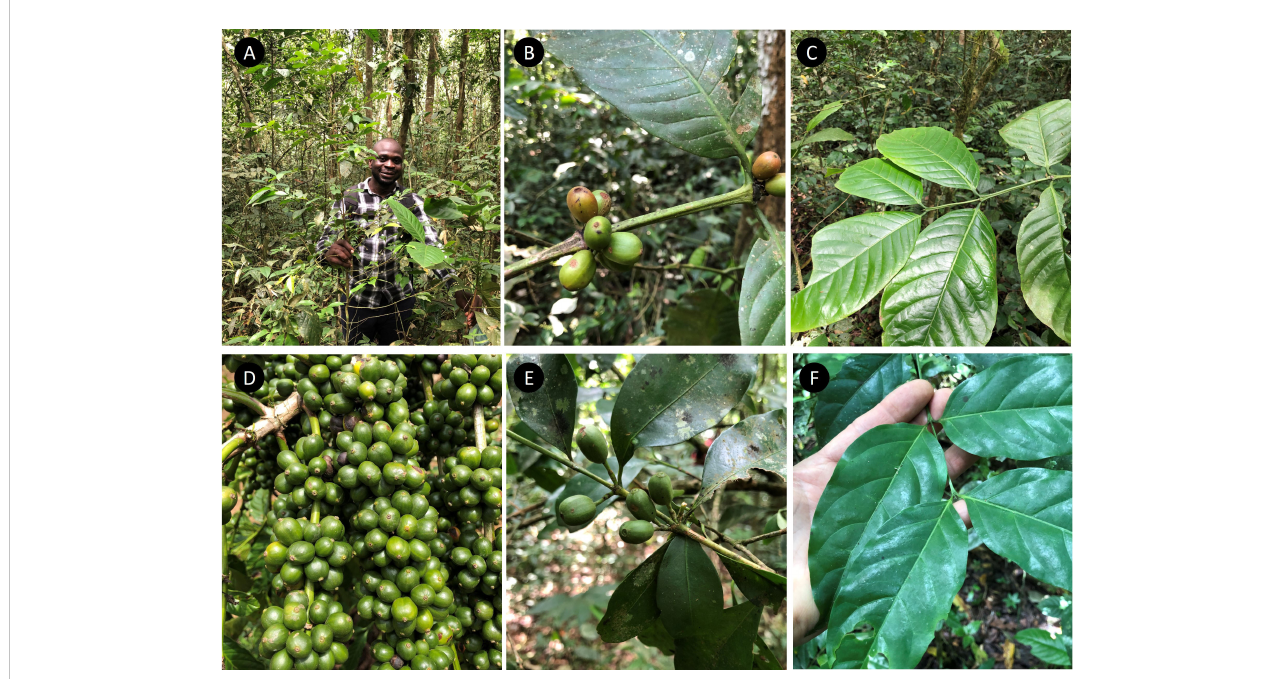
FIGURE 4 Coffea canephora (robusta coffee) and C. eugenioides . (A) Dr Robert Acidri: right hand holding C. canephora and left hand holding C. eugenioides ; (B) C. canephora , fruiting shoot (immature); (C) C. canephora , leaves; (D) C. canephora , unripe fruiting branch (immature); (E) C. eugenioides , fruiting branch (immature); (F) C. eugenioides , larger leaved variant. (A – C) , (E, F) : Itwara Forest (wild), western Uganda; (D) farmed in Masaka, central